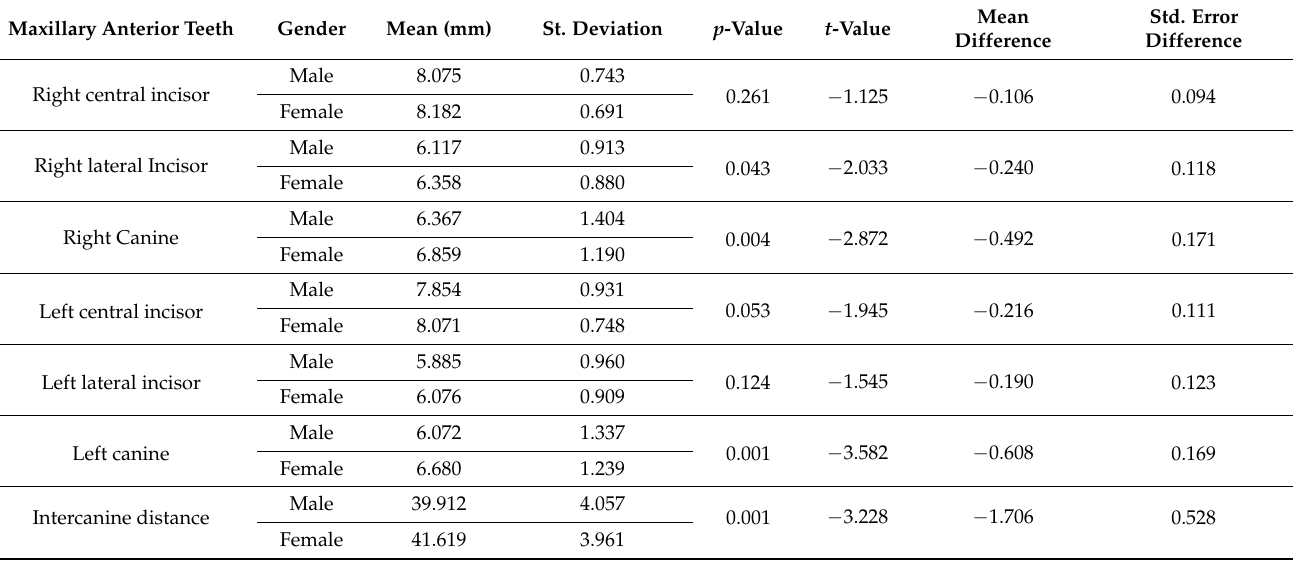
Table 5. The comparison of gender disparity in clean mesiodistal width of maxillary anterior teeth, independent t -test analysis (Male n = 112 Female n =